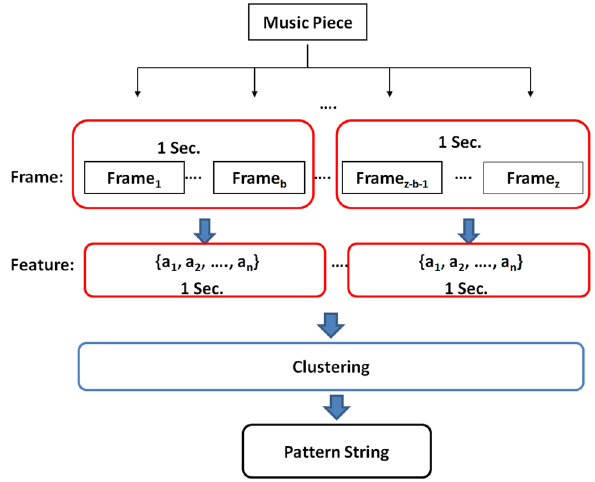
Fig. 6 Process of merging frames into a second-based pattern string